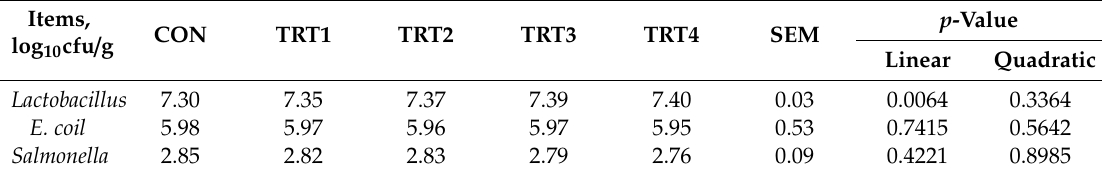
Table 5. E ff ect of coating the blend of OA and MCFA supplementation on excreta microflora in broilers. Items, log 10 cfu / g